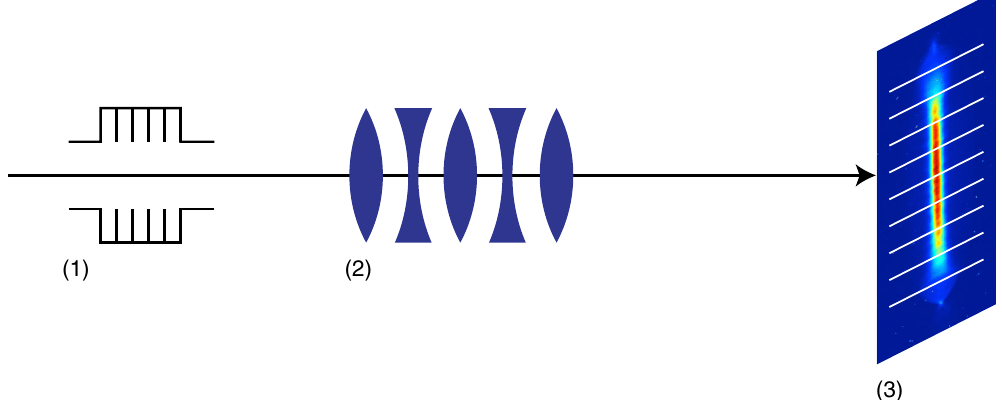
FIG. 6. Illustration of slice emittance measurements in a particle accelerator. The beam enters from the left and undergoes the following transformations: (1) mapping of the time axis onto the vertical angle by the transverse deflecting structure, (2) variation of the horizontal phase advance between the deflector and the profile monitor by adjusting the quadrupole lenses, while keeping the vertical phase advance approximately constant such that a vertical angle is transformed optimally into a vertical position, and (3) measurement of the horizontal beam size in several slices of the